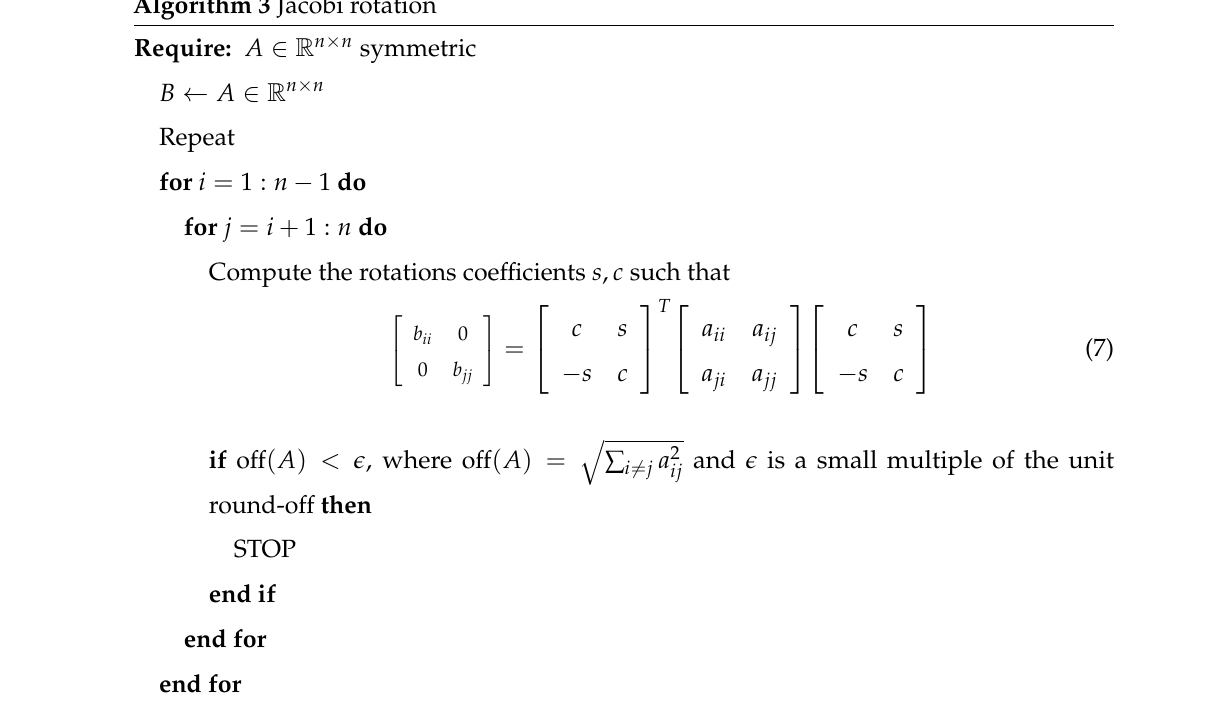
Algorithm 3 Jacobi